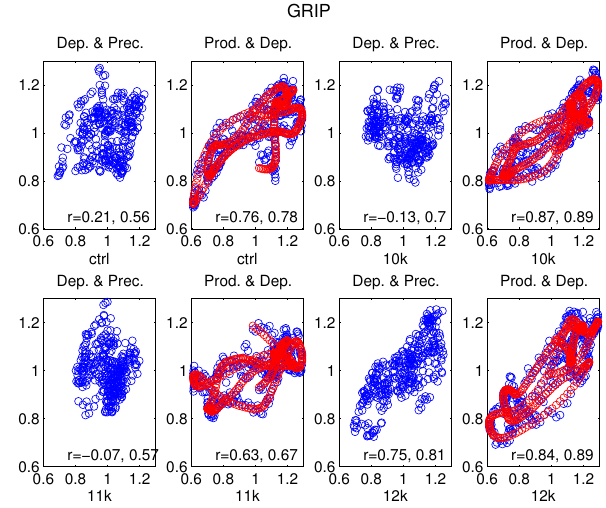
Fig. 11. Variability (%) explained by each IMF of 10 Be deposition for all simulations, both at GRIP (top) and Law Dome (bottom). Fig. 12. In blue: scatter plots and correlation coefficients (first Fig. 12. In blue: Scatter plots and correlation coefficients (first numbers) between variables (production: ’Prod.’, deposition: ’Dep.’ and precipitation: ’Prec.’) of 25-month running means at the GRIP station. In red: Scatter plots and correlation coefficients (second numbers) between the noise-filtered (IMFs 4-8) production and deposition.